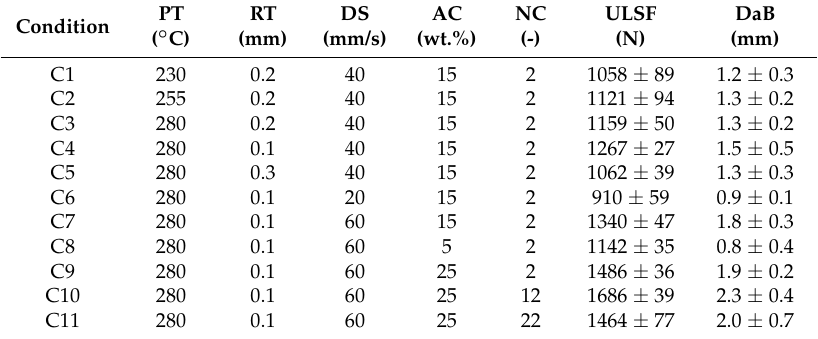
Table 5. Summary of the ULSF and DaB for the 11 conditions in the aluminum 2024-T3/ABS hybrid joints.